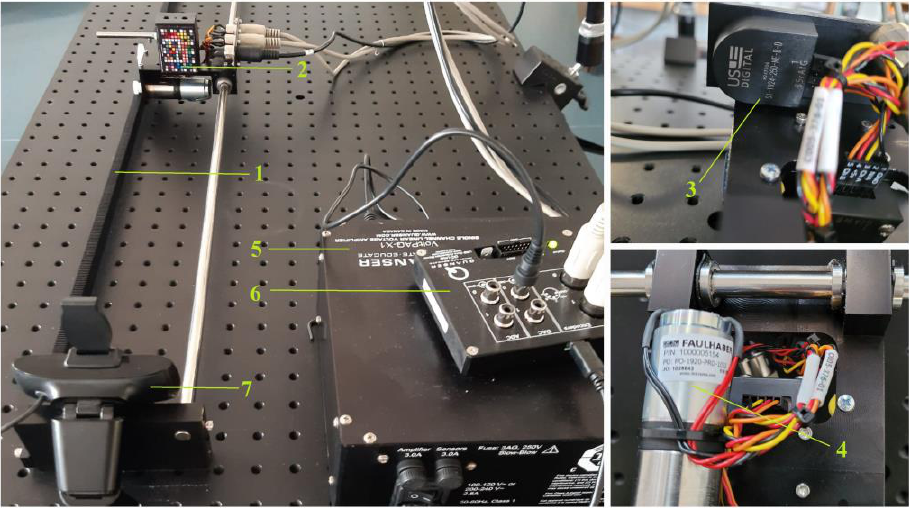
Figure 1. Experimental stand for video distance measurement testing.